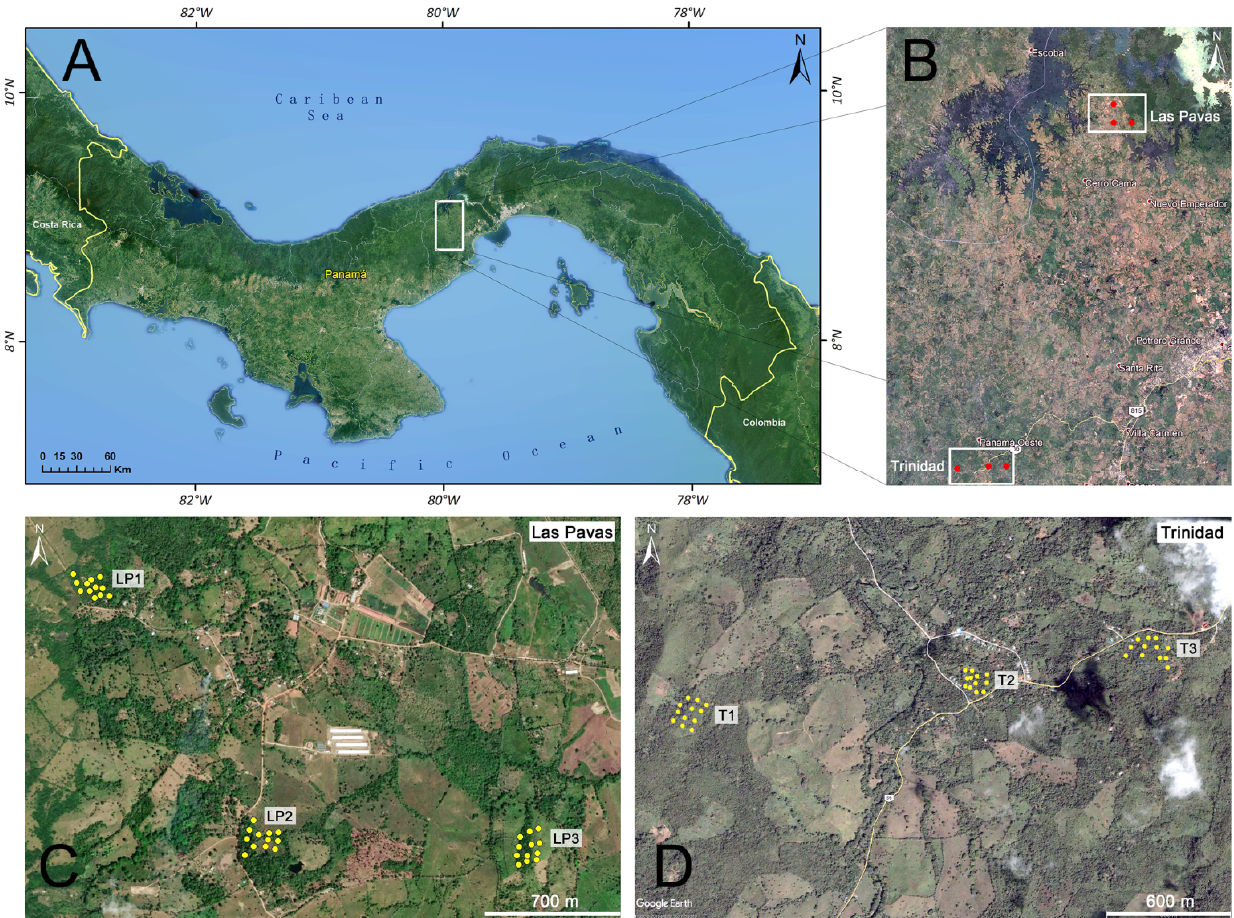
Figure 1. Geographic location of the communities Trinidad de las Minas (T) and Las Pavas (LP) in Panamá Oeste Province. ( A ) Map of Panamá and general study location. ( B ) Geographic location of study sites relative to each other. ( C ) Las Pavas (LP) sampling locations: peridomicile plot (LP1), partly wooded plot (LP2), wooded plot (LP3). ( D ) Trinidad de las Minas (T) sampling locations: wooded plot (T1), peridomicile plot (T2), partly wooded plot (T3). Numbers in the plot labels were assigned from west to east. Wooded plots are covered by primary forest, while peridomicile and partly wooded plots are a mixture of secondary vegetation and standing trees, the peridomicile plots being within a 100m radius from households. The images in this figure are courtesy of Google and were accessed from Google Earth, version 7.3.3.7786 (earth.google.com/web/). The figure was elaborated with Arcmap (ESRI 2011) and CorelDRAW, version X7 (17).